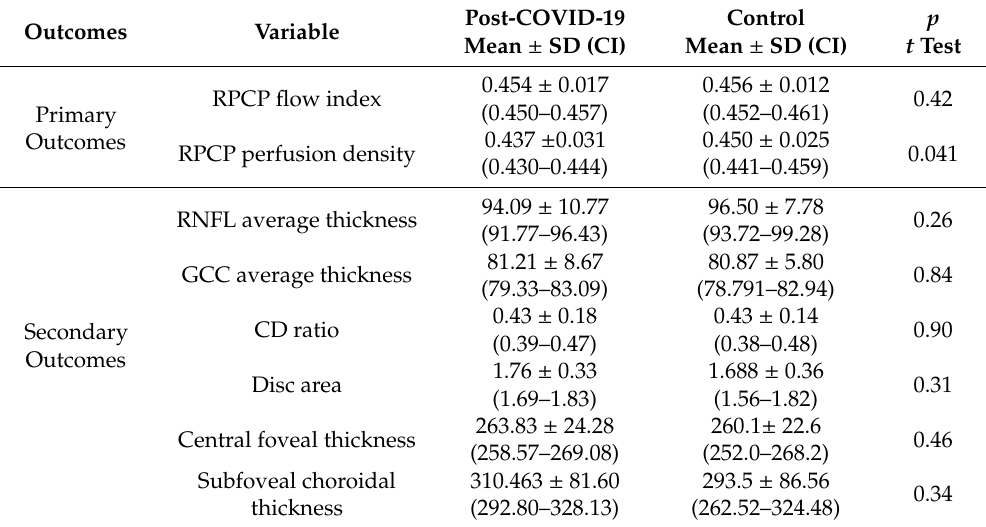
Table 3. Analysis of primary and secondary outcomes in the study